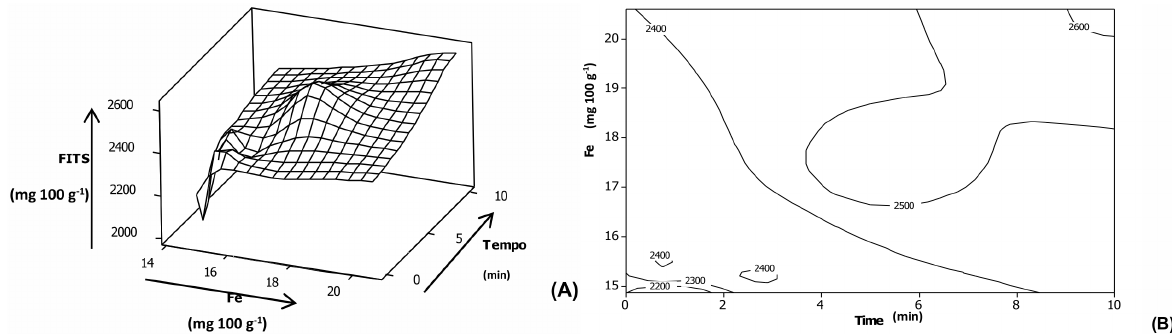
Figure 2. (a) Response surface; (b) Contour plot to study minimization of the response predicted by the model in relation to the iron compound and time in